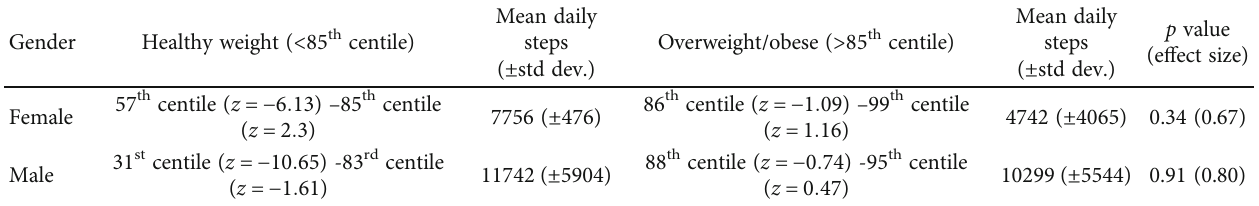
Table 2: Comparison of daily steps across healthy weight and overweight BMI centile categories ( mean ± std dev : ). Gender Healthy weight ( < 85 th centile)